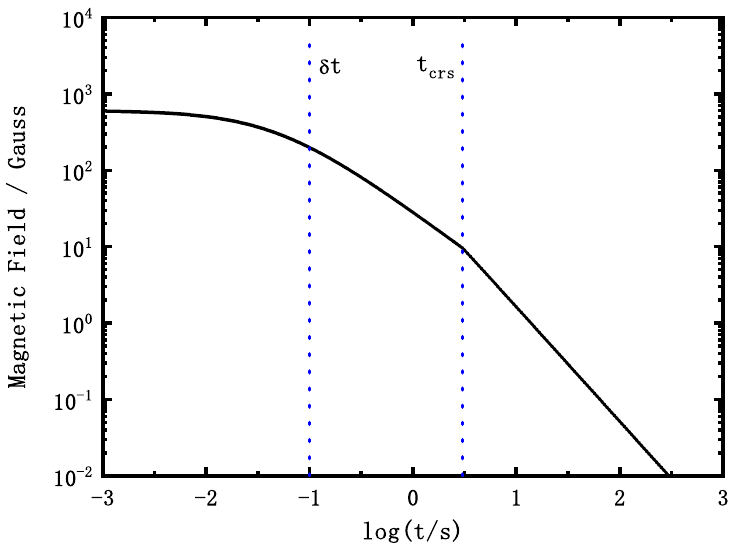
Figure 1. The magnetic field as a function of time. The two blue vertical dotted line represents the redefined interval δ t = 0.1 s and the shock crossing time t crs = 3 s, respectively. After the shock crossing time, the merged shell expands adiabatically and s = 3 is assumed. The dynamics parameters L k = 10 51 ergs − 1 , γ 1 = 300, γ 4 = 30,000, p = 2.5, (cid:101) e = 0.3, (cid:101) B = 0.3, and z = 1 are taken from numerical